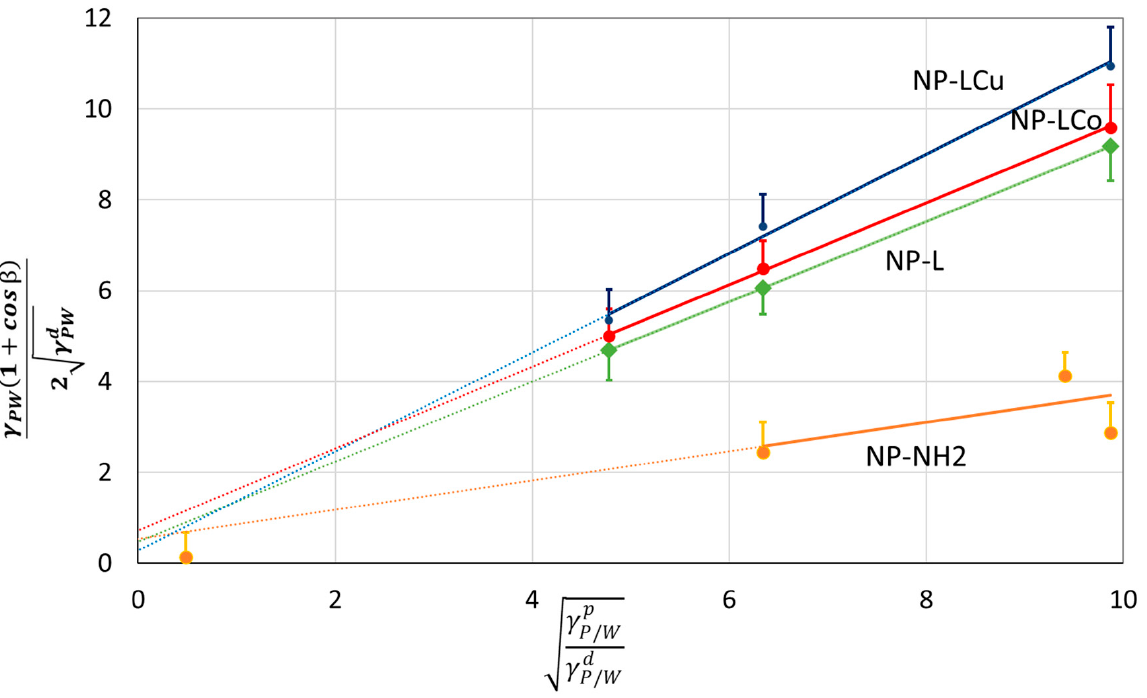
Figure 5. The linear OWRK equation was constructed from the experimental data of the contact angle measured from the circular traces left by the nanoparticles NP-NH 2 , NP-L, NP-LCu and NP-LCo. The error bars represent the standard error and are represented only on the positive or negative side of the measured average value.